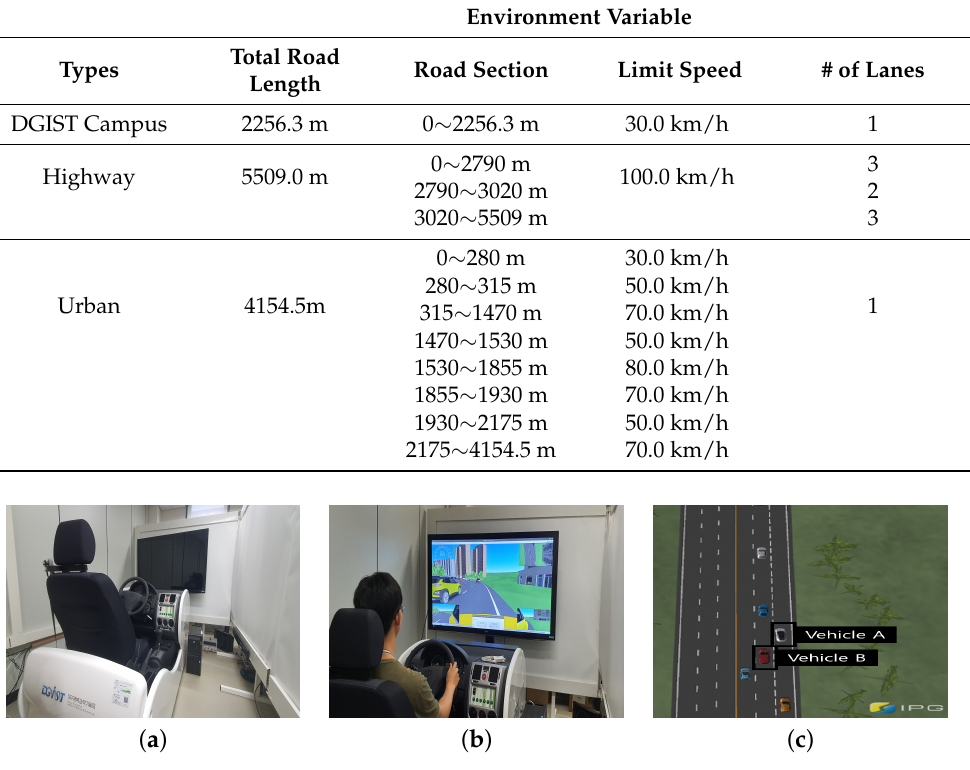
Figure 10. CarMaker simulation environments for dataset generation: ( a ) Driving environment. ( b ) Simulation driving. ( c ) Simulation